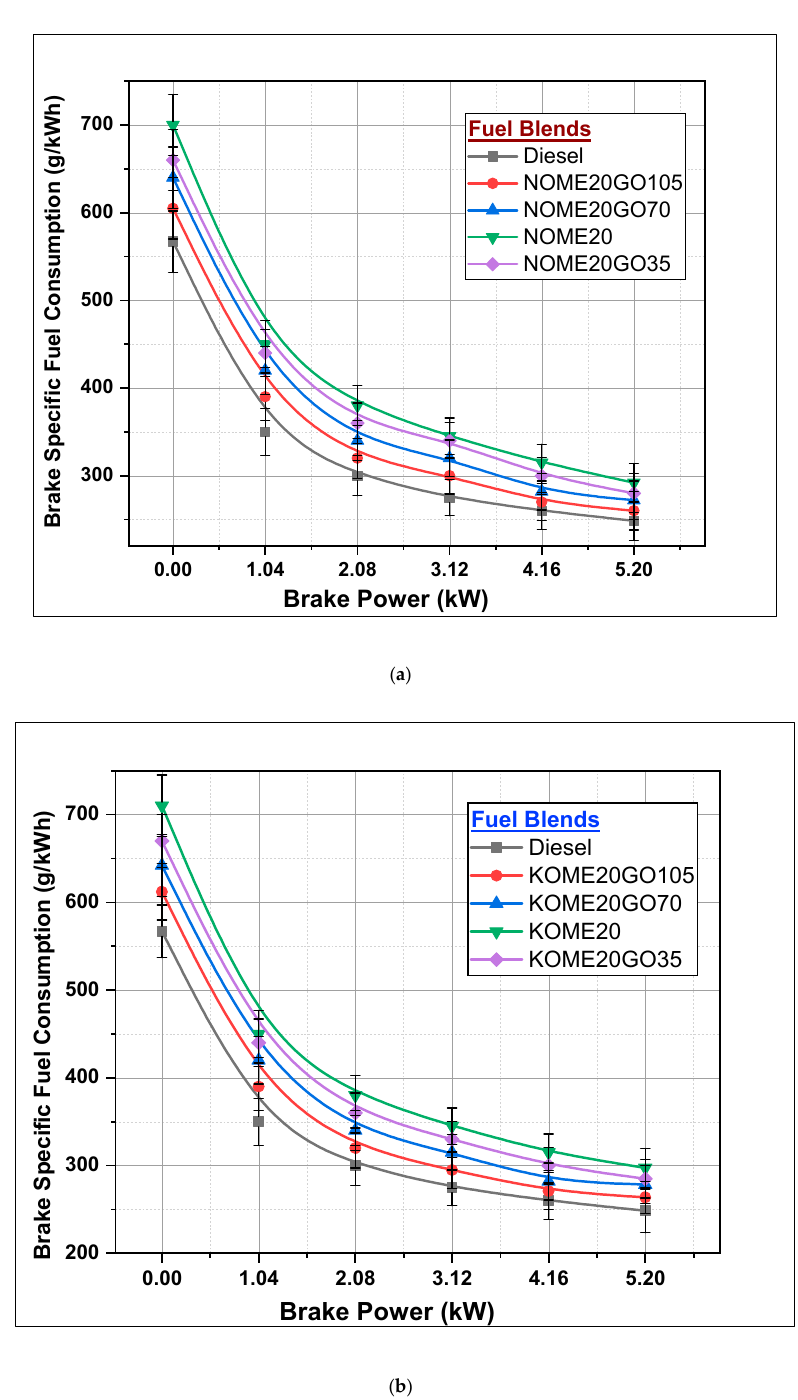
Figure 11. Variation of brake-specific fuel consumption with Biodiesel-Diesel-Nano blends ( a ) NOME20 ( b ) KOME20.